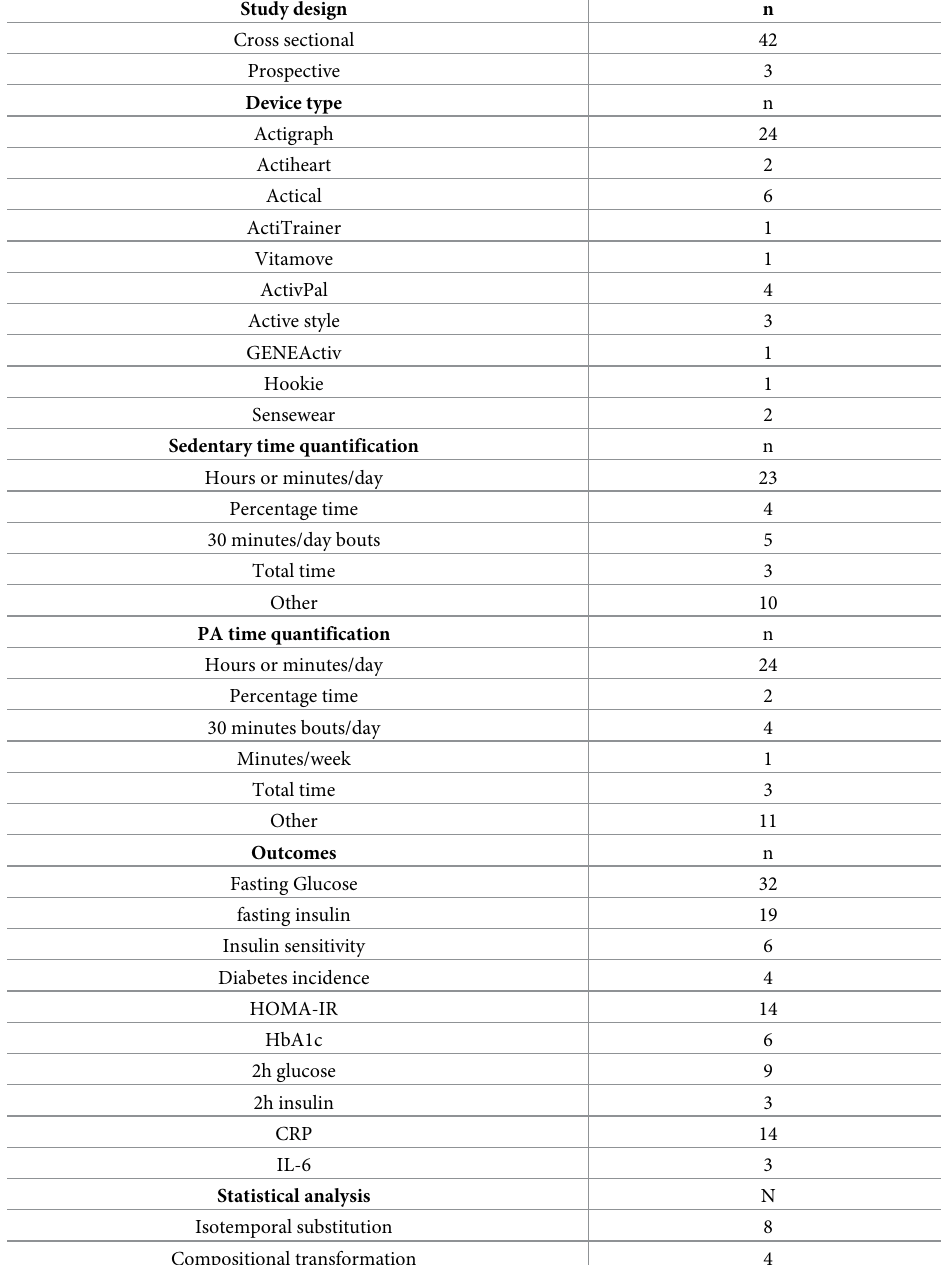
Table 1. Characteristics of the selected